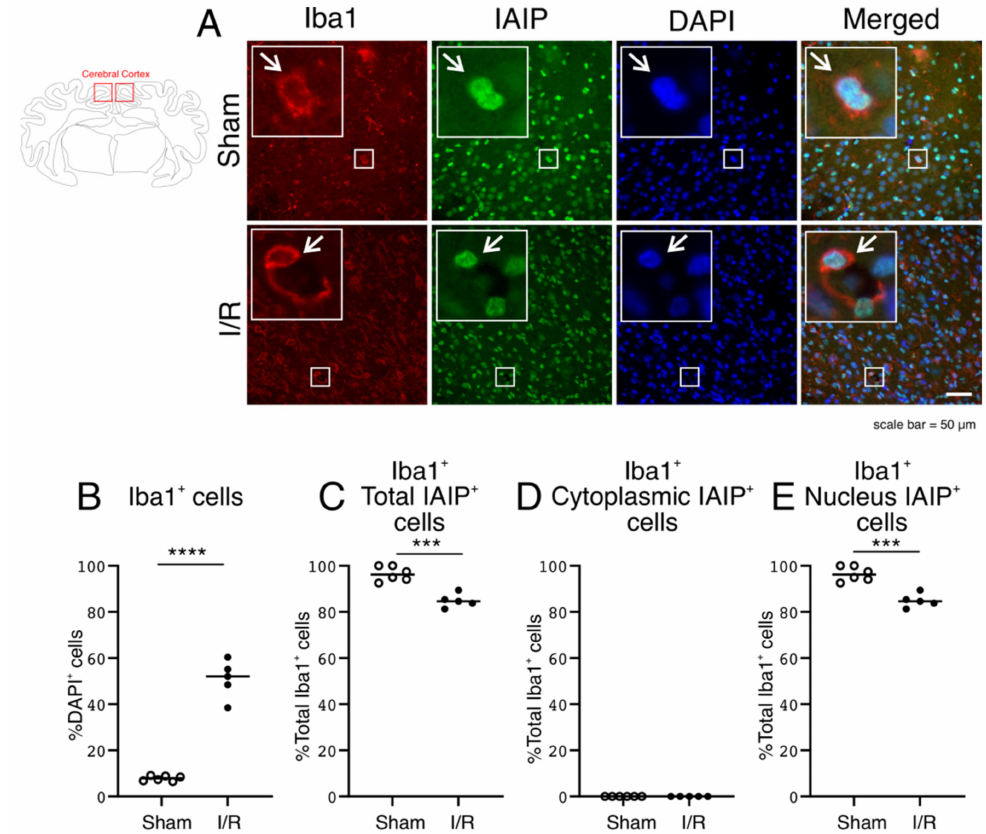
Figure 4. Subcellular localization of IAIPs in microglia in the cerebral cortex. Schematic diagram of sheep brain indicates regions, from which cerebral cortical samples were taken. ( A ) Representative images of microglia (Red), IAIPs (Green), DAPI-positive cells (Blue) and merged double immunos- taining in the cerebral cortex of fetal sheep in Sham and I/R groups. Magnification, 40 × . Each inset contains the extended images. Scale bar = 50 µ m. Arrows indicate the same cell. ( B ) Quantifica- tion of Iba1 positively stained cells. Iba1 positive cells expressed as a percentage of DAPI-positive cells plotted on the y -axis for the Sham (open circles) and I/R (closed circles) groups on the x -axis. Values median and scattergrams. ** p < 0.01 . ( C – E ) Quantification of IAIP positive Iba1 microglia. IAIPs positive Iba1 positive microglia plotted as a percentage of Iba1 positive microglia on the y -axis for total ( C ), cytoplasmic ( D ), and nucleus ( E ) compartments for the Sham (open circles) and I/R (closed circles) groups on the x -axis. Values median and scattergrams. *** p < 0.001, **** p < 0.0001